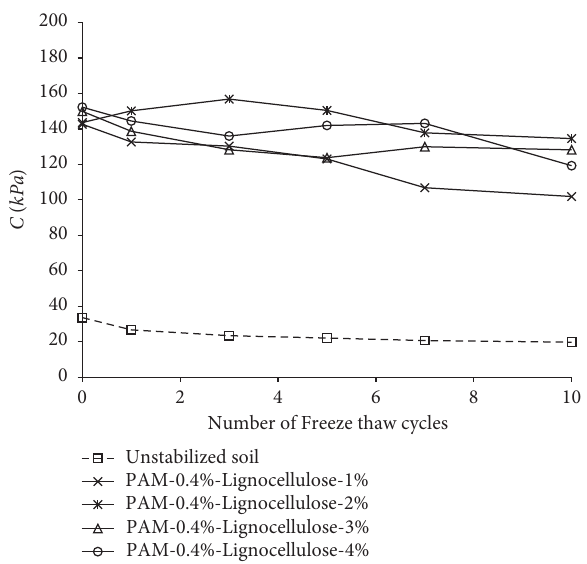
Figure 16: Changes of cohesion of stabilized PAM and lignocellulose samples with freeze-thaw cycles.